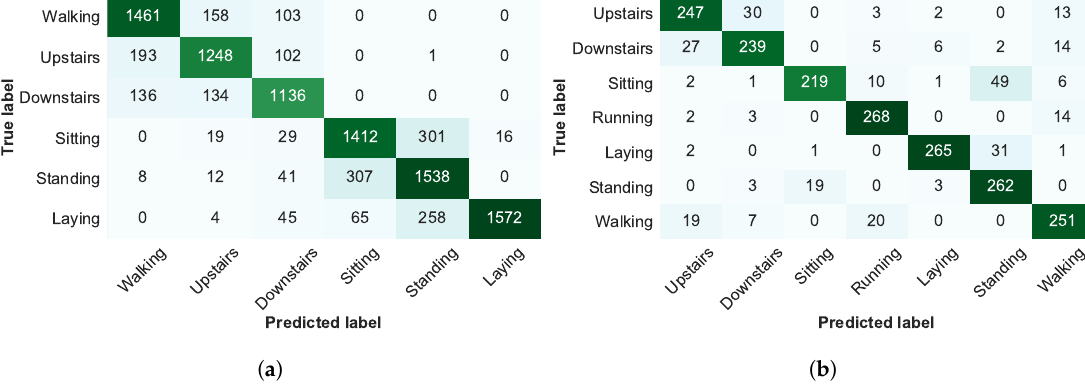
Figure 12. Confusion matrix for the Self-Training Semi-Supervised Active Learning (ST-SSAL) method using the Overall Uncertainty Classification-Change Stopping Criterion (Over-CC SC). ( a ) UCI dataset. ( b ) CADL